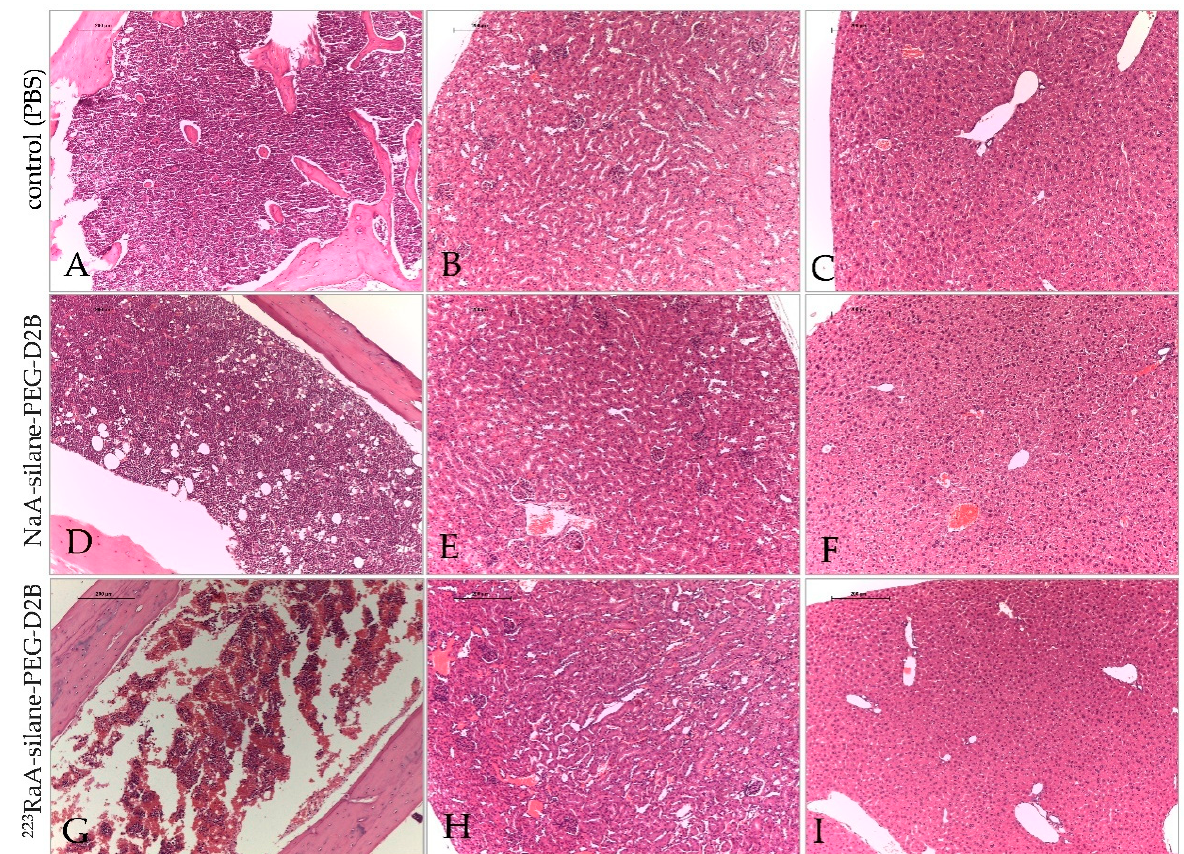
Figure 8. Representative images of bone marrow, kidneys and liver sections after exposure of BALB/c mice to NaA-silane- PEG-D2B and 223 RaA-silane-PEG-D2B for 7 days. Bone marrow ( A ), kidneys ( B ) and liver ( C ) sections from control (PBS) mice. Bone marrow ( D ), kidneys ( E ) and liver ( F ) sections from mice after exposure to NaA-silane-PEG-D2B. Bone marrow ( G ), kidneys ( H ) and liver ( I ) sections from mice after exposure to 223 RaA-silane-PEG-D2B. Scale bars, 200 mcm. Table 1. Comparison of blood morphology data between first and seventh day after 223 RaA-silane-PEG and 223 RaA-silane- PEG-D2B injection into BALB/c mice. * statistically significant.